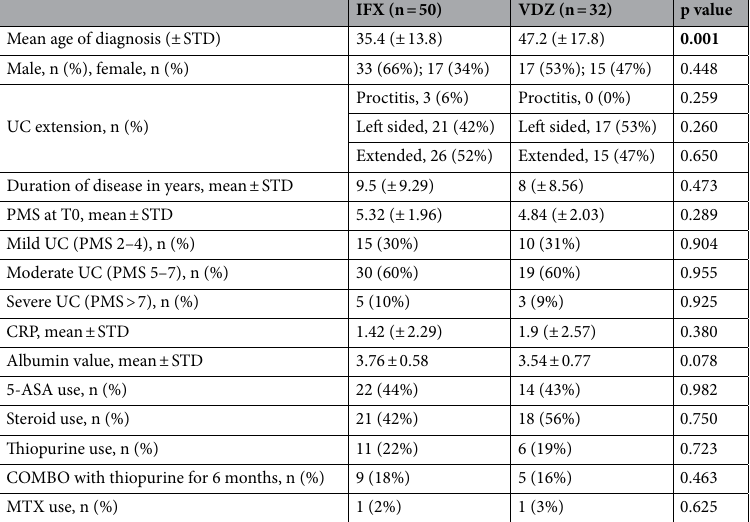
Table 1. Clinical characteristics of the study populations. p value was obtained by chi-square, exact Fisher, and t Student’s test. STD standard deviation (STD), PMS partial mayo score, CRP C-reactive protein, MTX Methotrexate. Significant values are in